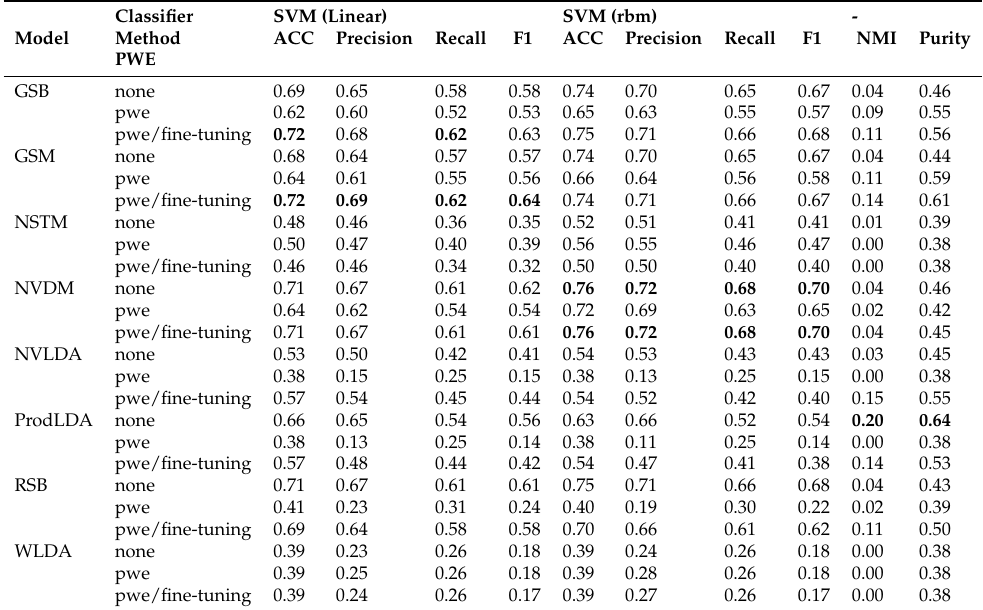
Table 26. Classification and Clustering performance on DBLP.